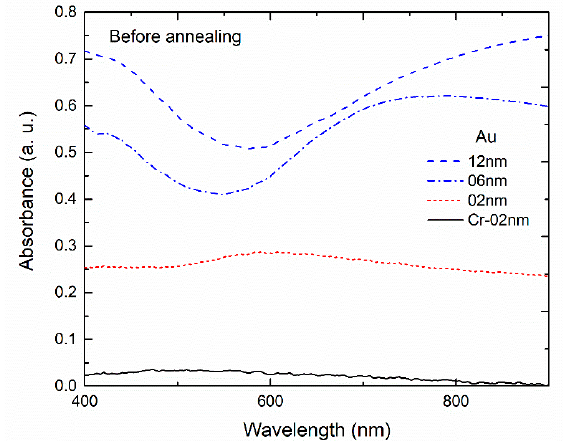
Figure 6. Absorption spectra before annealing of planar samples with 2, 6 and 12 nm gold thin film deposited on substrates with 2 nm of chromium (adhesion layer) and of a sample with 2 nm chromium thin film.